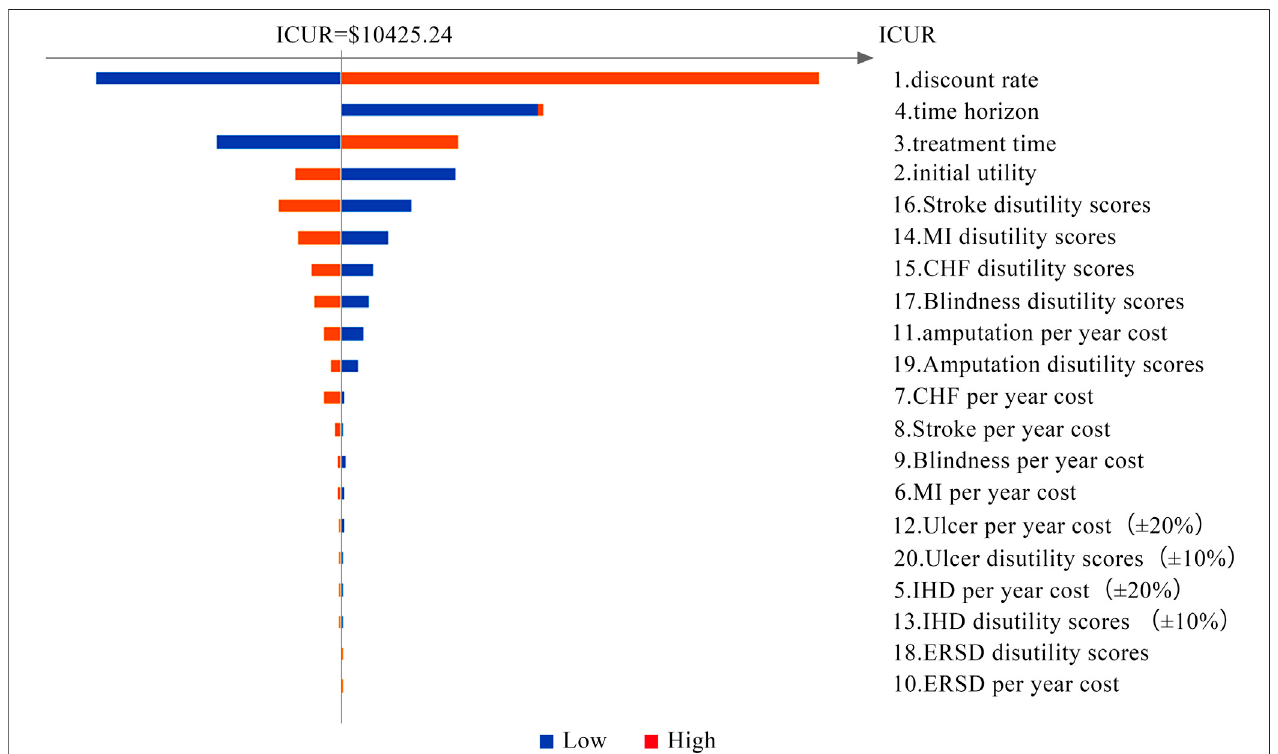
FIGURE 2 | Tornado diagram of the one-way SA (at C λ (cid:2) $708.11).